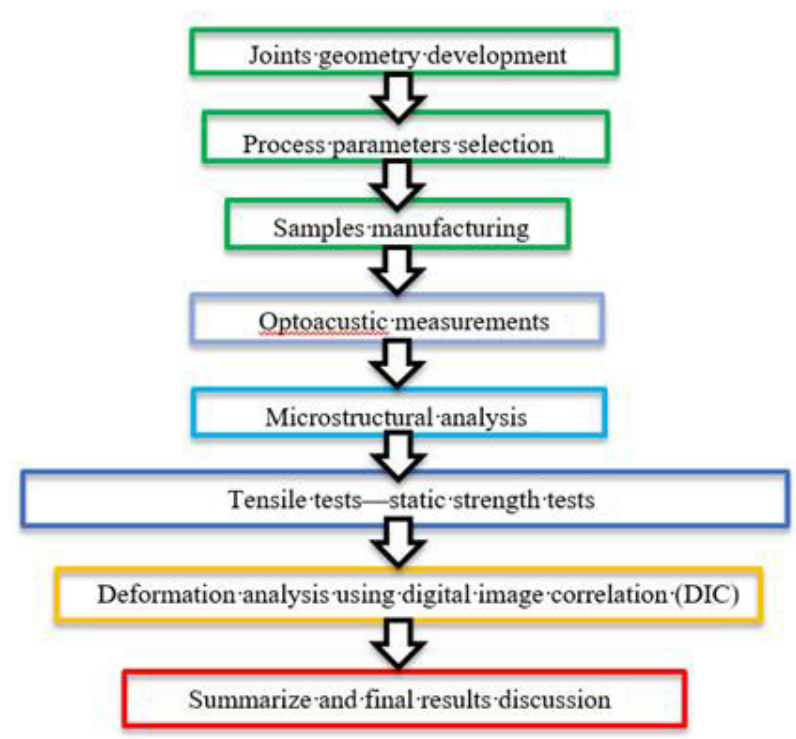
Figure 6. Illustration of the research methodology employed in this study.